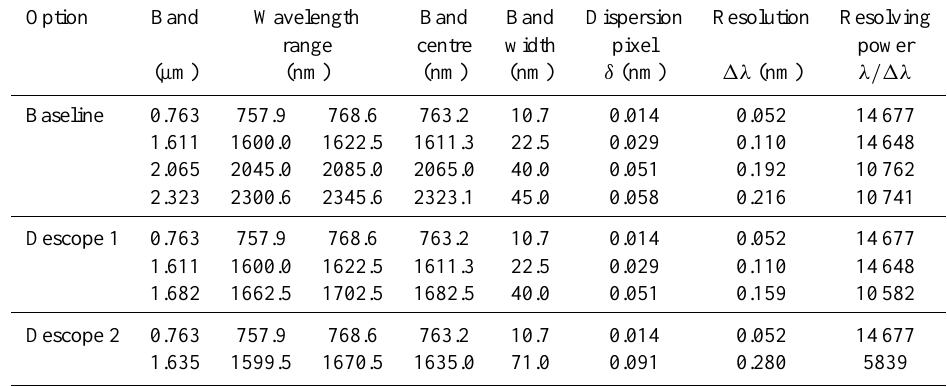
Table 1. Spectral ranges and resolutions of the geoCARB bands for the baseline and descope options. Option Band